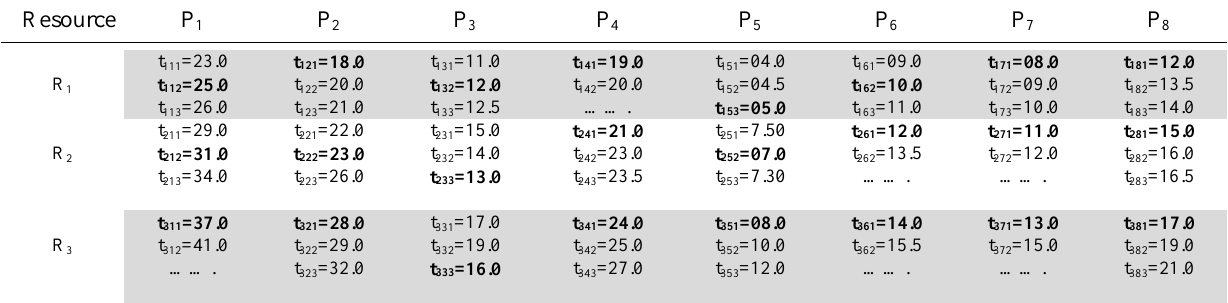
Database of machining time of various product-resource combinations using multiple process plans